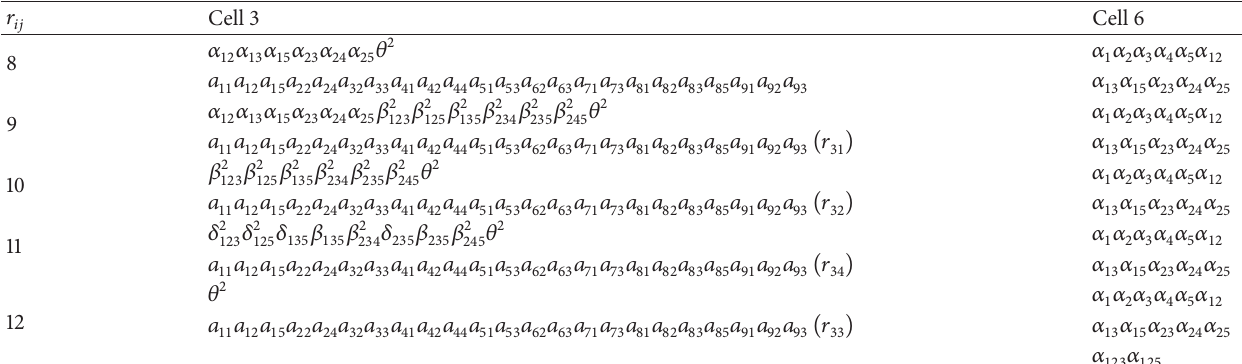
Table 5: Generation of frequent 3-itemsets.